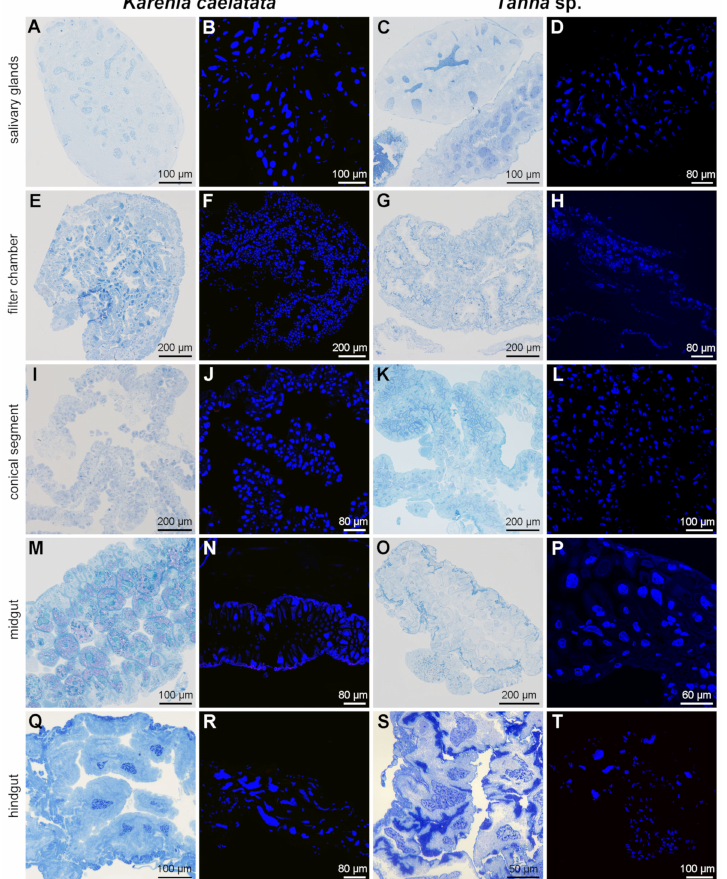
Figure 5. Histological and fluorescence microscopy showing the distribution of Sulcia and YLS in the salivary glands, filter chamber, conical segment, midgut, and hindgut of Karenia caelatata and Tanna sp. ( A , B ) Distribution of Sulcia and YLS in the salivary glands of K. caelatata. ( C , D ) Distribution of Sulcia and YLS in the salivary glands of Ta . sp. ( E , F ) Distribution of Sulcia and YLS in the filter chamber of K. caelatata. ( G , H ) Distribution of Sulcia and YLS in the filter chamber of Ta . sp. ( I , J ) Distribution of Sulcia and YLS in the conical segment of K. caelatata. ( K , L ) Distribution of Sulcia and YLS in the conical segment of Ta . sp. ( M , N ) Distribution of Sulcia and YLS in the midgut of K. caelatata. ( O , P ) Distribution of Sulcia and YLS in the midgut of Ta . sp. ( Q , R ) Distribution of Sulcia and YLS in the hindgut of K. caelatata. ( S , T ) Distribution of Sulcia and YLS in the hindgut of Ta . sp. For fluorescence microscopy, blue represent the